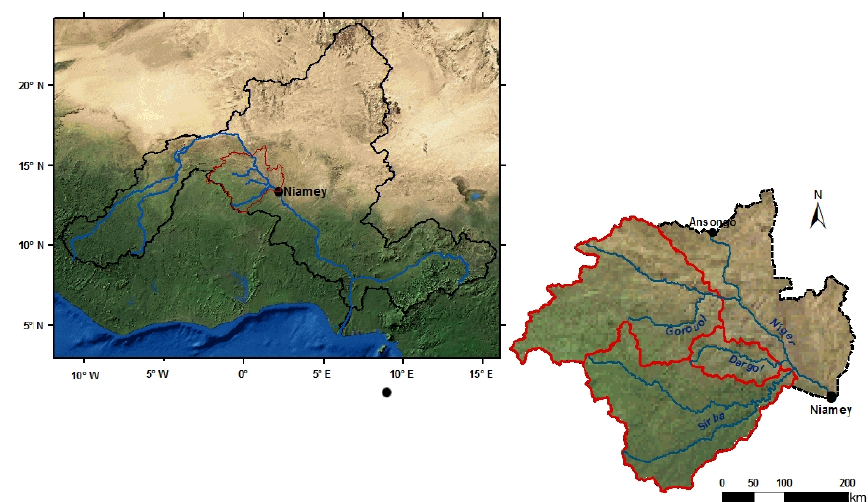
Figure 1. Map of the Niger basin (top left) and the zoomed in image of the Ansongo–Niamey reach basin (bottom right). The red contours on the bottom right plots delineate the three main tributaries contributing to the red flood (C. Casse and L. Gal, based on SIEREM and NOAA